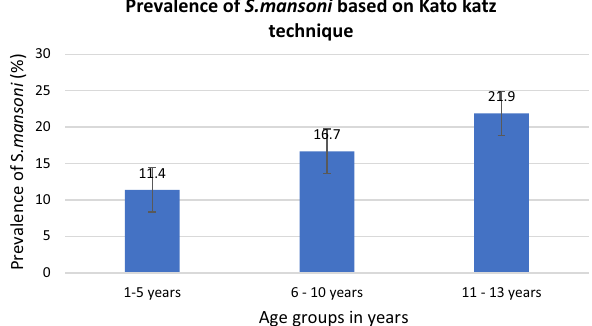
Figure 1. Prevalence of S. mansoni based on Kato Katz technique among pre-school and school aged children in villages surrounding Lake Nyasa, Southern Tanzania.